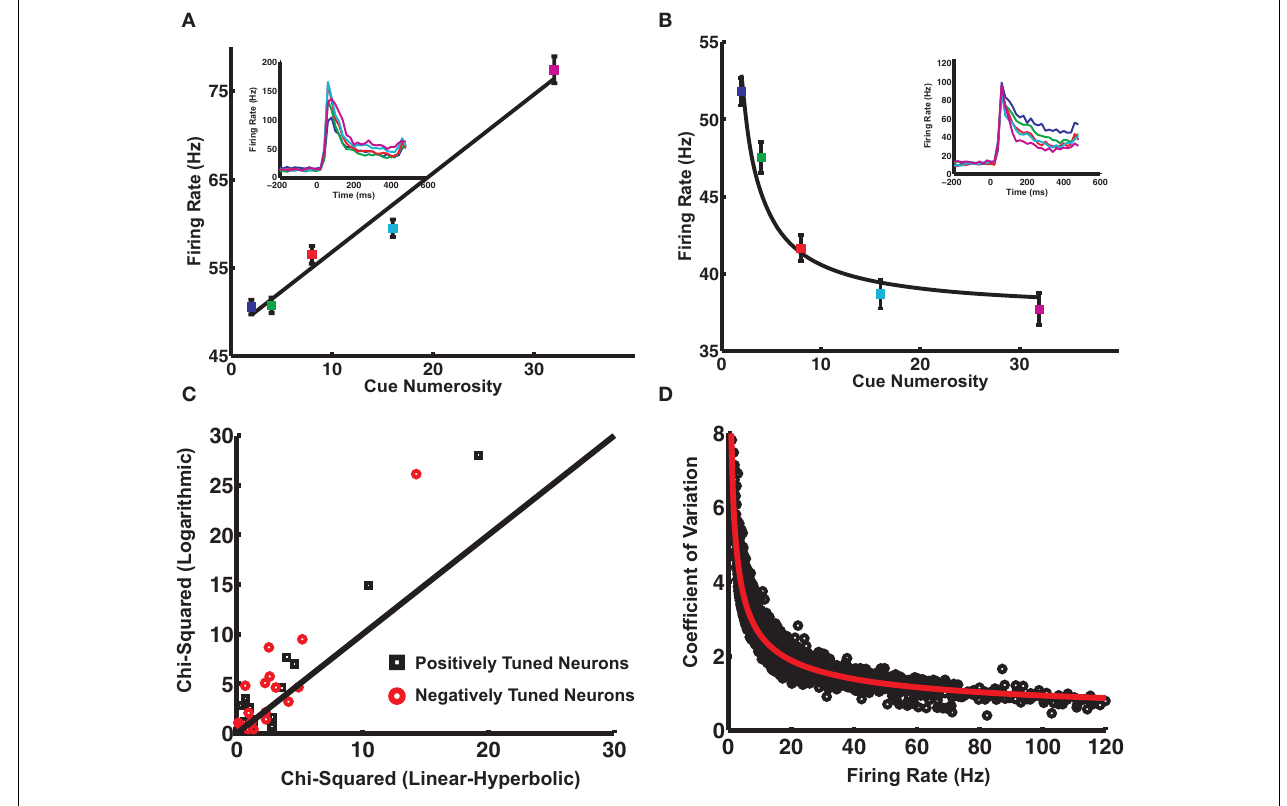
FIGURE 2 | Single neurons in LIP monotonically encode the number of visual objects. (A) Averaged single neuron ( n = 15) fi ring rate during the cue presentation for fi ve different numerosities (after Roitman et al., 2007; see Materials and Methods). Standard and deviant trials were averaged. Data are fi t to a straight line. Inset shows PSTH of an example neuron for fi ve different numerosities. Colors in the PSTH correspond to data points in the main plot. (B) Average fi ring rate (n = 17) for negatively monotonic neurons in LIP. Inset shows the PSTH for an example neuron. Data were fi t to a hyperbolic decay. Colors are as in (A). (C) 2 goodness-of-fi t comparison between linear-hyperbolic and